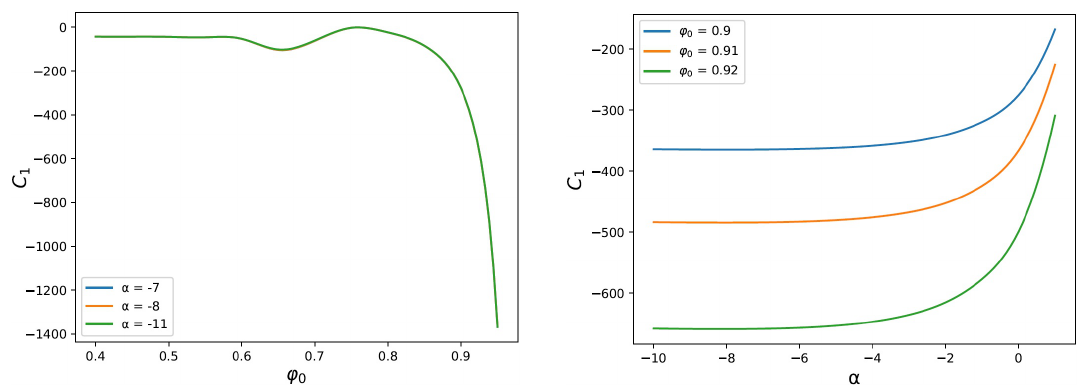
, for Nut end-point 0